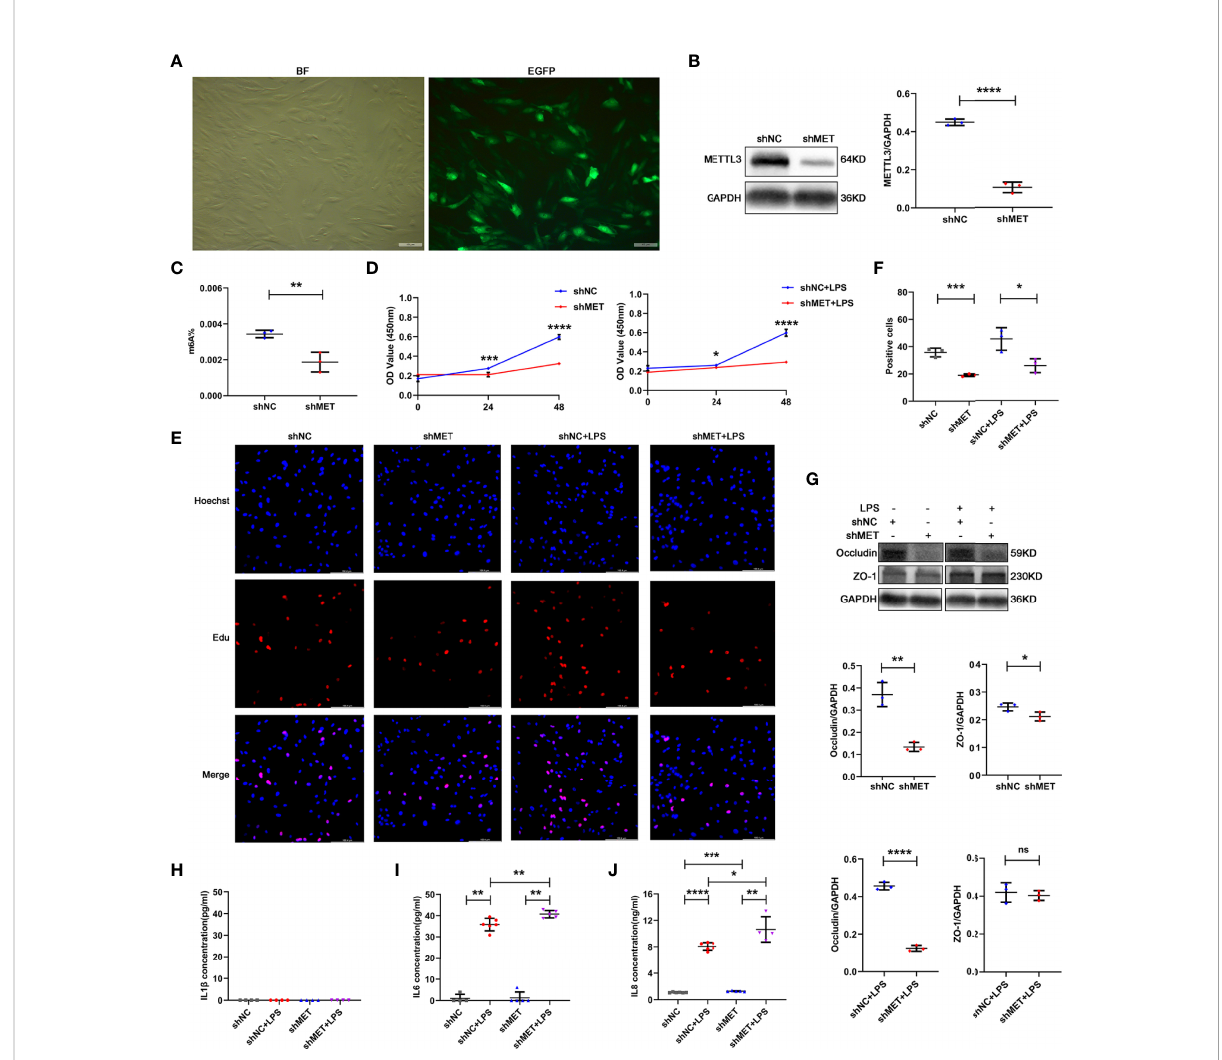
FIGURE 2 Phenotype of hRPE cells after silencing METTL3. (A) Transfection ef fi ciency of the METTL3-silenced lentivirus in hRPE cells (BF, bright fi eld; EGFP, enhanced green fl uorescence protein; scale bar, 10 m m). (B) Silencing ef fi ciency of METTL3 in hRPE cells. Left, representative western blotting images of METTL3. shMET, shMETTL3; shNC, Negative Control. Right, quanti fi cation of relative expression of METTL3 (mean ± SD; **** P<0.0001; n=3/group; unpaired Student ’ s t-test). (C) m 6 A% after silencing METTL3 in hRPE cells (mean ± SD; ** P<0.01; n=3/group; unpaired Student ’ s t-test). (D) Cell viability of hRPE cells after silencing METTL3 with or without LPS stimulation (mean ± SD; * P<0.05, *** P<0.001, **** P<0.0001; n=6/group; unpaired Student ’ s t-test). (E, F) Proliferation of hRPE cells. (E) Representative Edu images of hRPE cells after silencing METTL3 with or without LPS stimulation (scale bar, 166.4 m m). (F) Quanti fi cation of Edu positive cells (mean ± SD; * P<0.05, *** P<0.001; n=3/ group; one-way ANOVA). (G) Protein levels of Occludin and ZO-1 in hRPE cells after silencing METTL3 with or without LPS stimulation. Upper, representative western blotting images of Occludin and ZO-1. Lower, quanti fi cation of relative expression of Occludin and ZO-1 (mean ± SD; ns P>0.05, * P<0.05, ** P<0.01, **** P<0.0001; n=3/group; unpaired Student ’ s t-test). (H – J) The secretion levels of IL-1 b , IL-6 and IL-8 in hRPE cells after silencing METTL3 with or without 24 hours of LPS stimulation (mean ± SD; * P<0.05, ** P<0.01, *** P<0.001, **** P<0.0001; n=4-6/ group; one-way